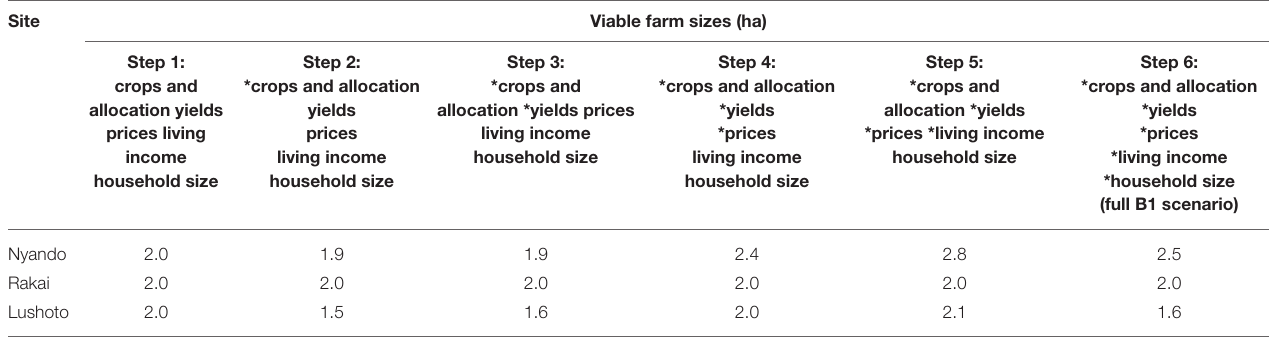
TABLE 3 | Viable farm sizes without or with the site-specific values per variable that were included in estimating the viable farm size, using scenario B1: baseline yields . Site Viable farm sizes